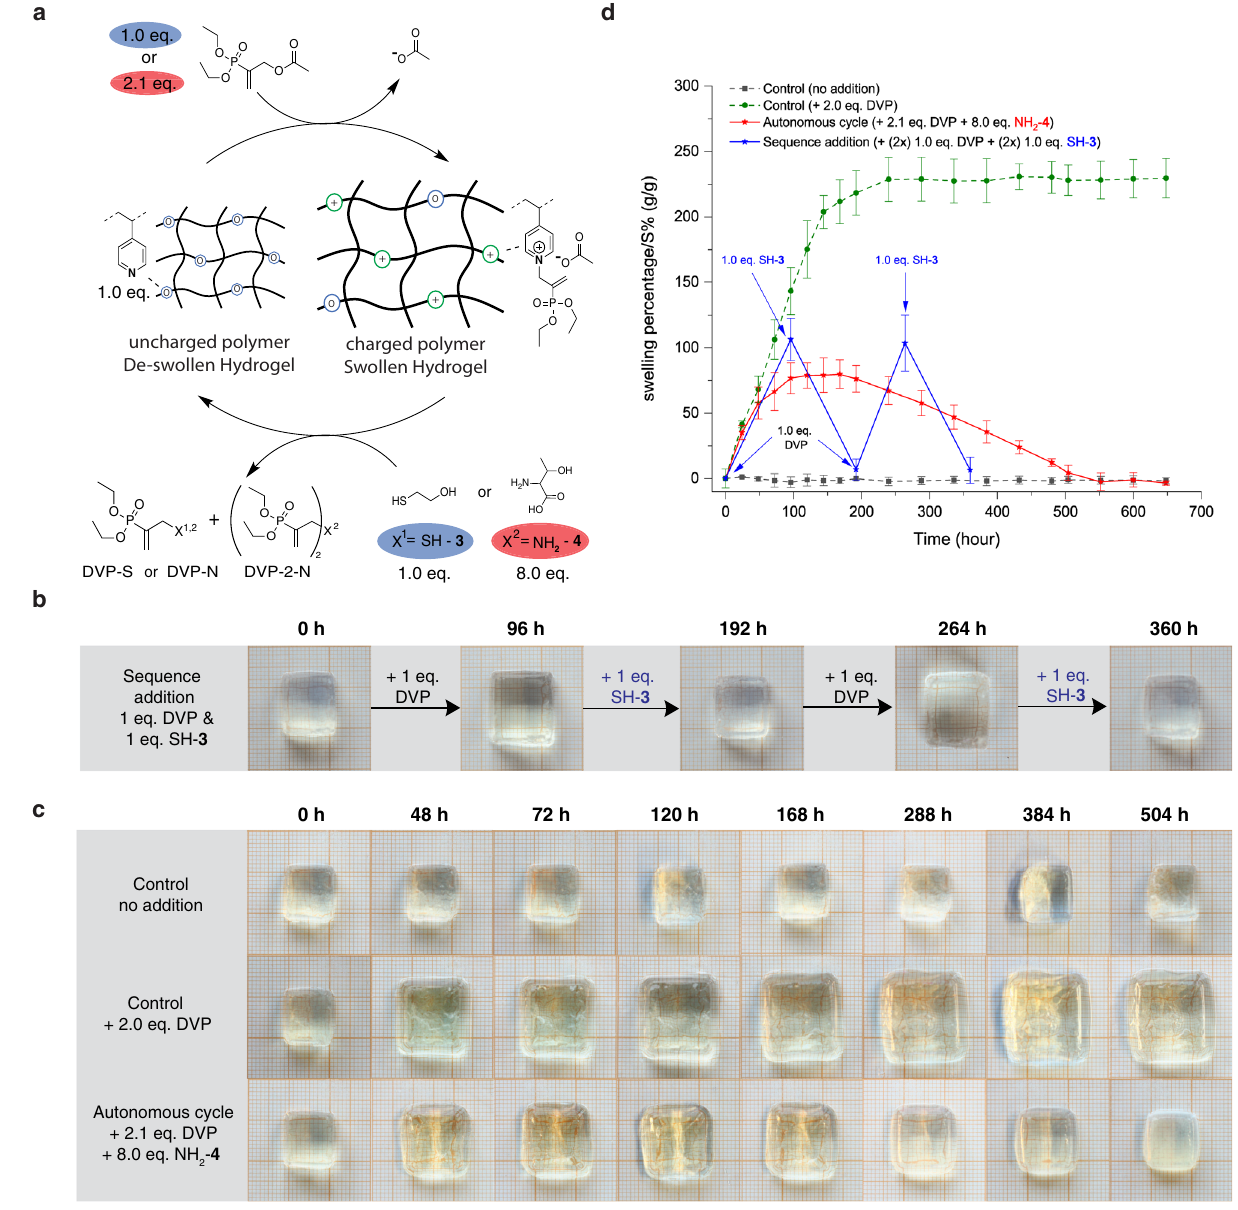
Fig.5|Temporallyprogrammedhydrogelswellingandde-swelling.a Hydrogel (de)swelling using signal-responsive or autonomous CRN strategy. The transition fromun-swollentoswollenstatewasmonitoredvisuallybytime-lapsephotographs on millimetre paper and via hydrogel weight measurements (run in triplet) over time in phosphate buffer (pH=7.4, 0.1M) at room temperature. b Time-lapse photographs of signal-responsive hydrogels without solution. c Time-lapse